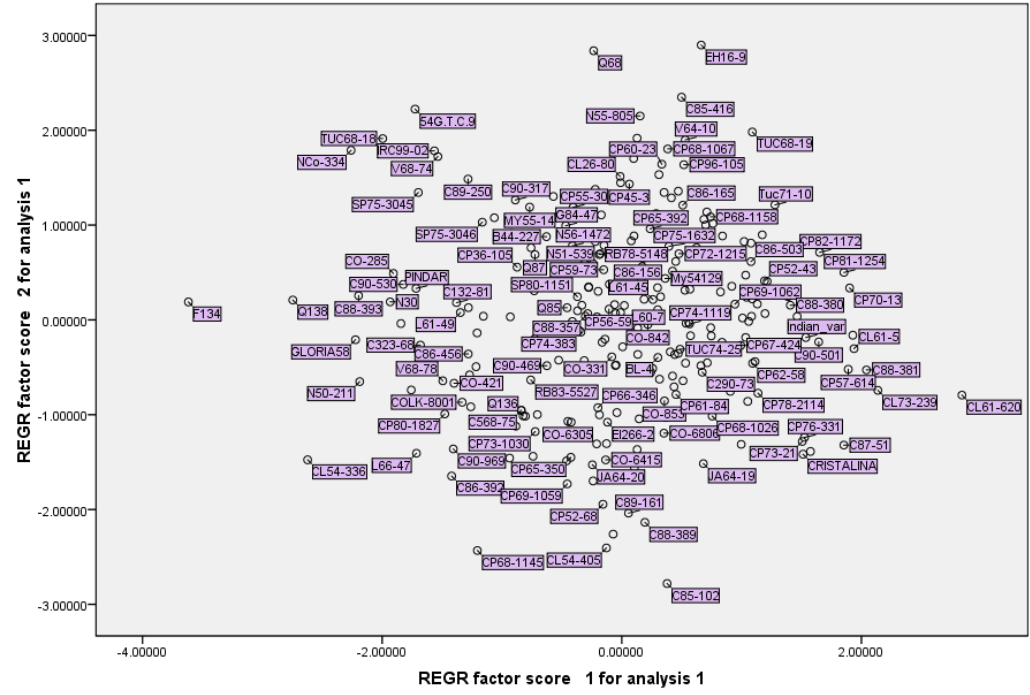
Figure 2. Two-dimensional scatter plot of principal component analysis for the first two principal components created from phenotypic traits from the sugarcane collection ( Saccharum spp.) in Khuzestan province, Iran.